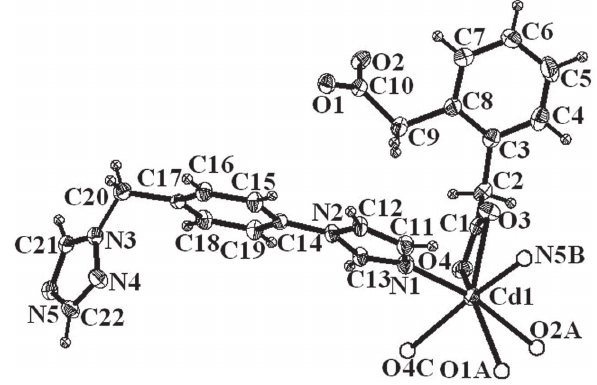
The asymmetric unit of the title crystal structure is shown in the figure. Tables 1 and 2 contain details of the measurement method and a list of the atoms including atomic coordinates and displacement parameters.